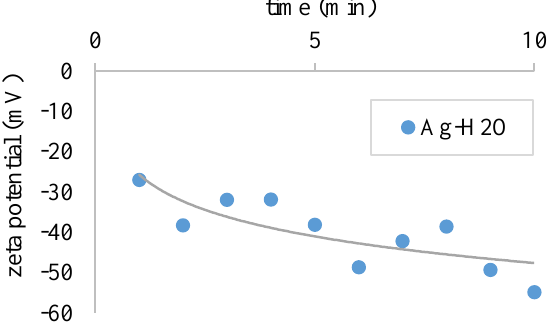
Figure 14. Zetapotential after sonication process. The line is inserted manually to guide the eyes. Measurements of the temperature field were conducted at two different flow rates of 7.7 mL/s and 9.5 mL/s, which correspond to an average flow velocity of 0.84 cm/s and 1.04 cm/s, respectively.